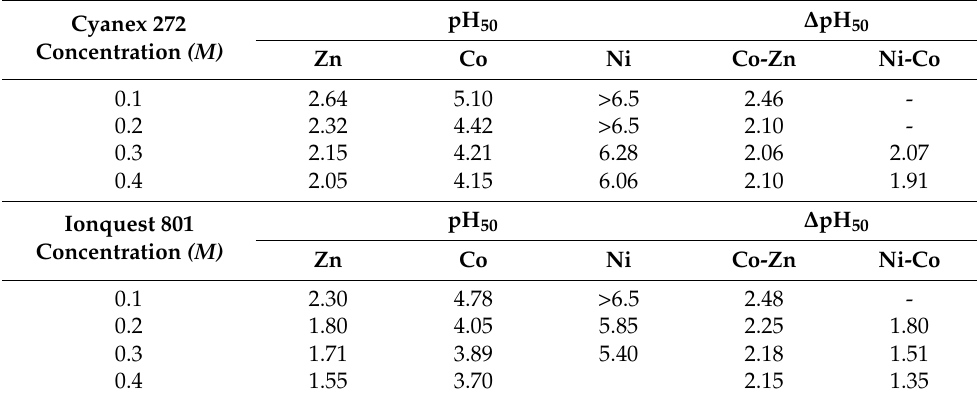
Table 1. Metal extraction pH 50 and ∆ pH 50 with various concentrations of Cyanex 272 and Ionquest 801.